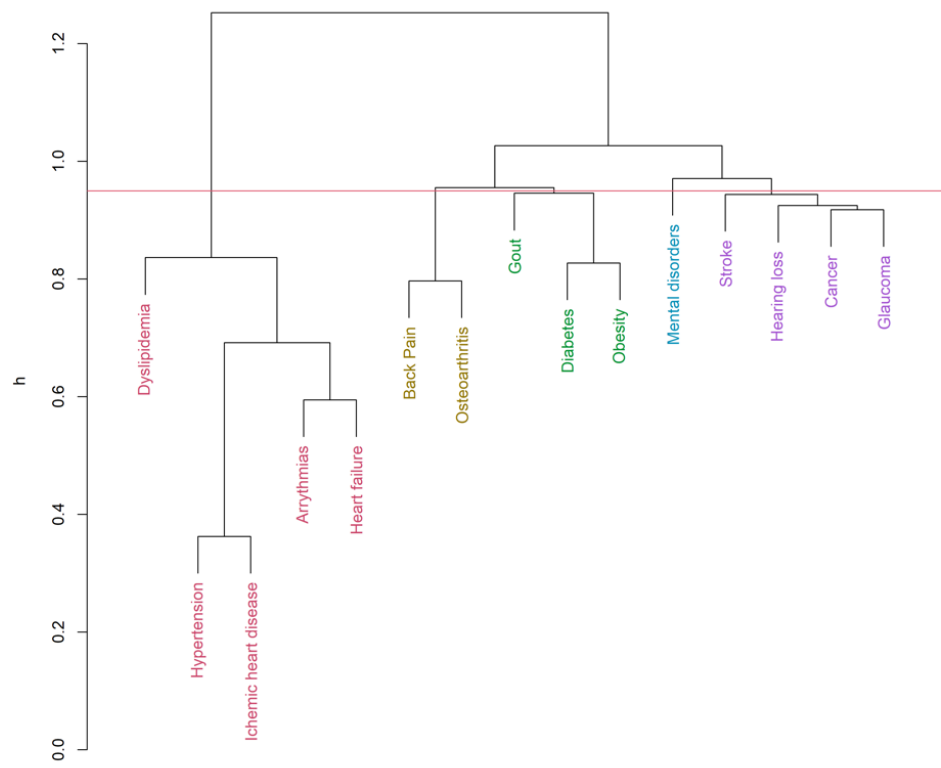
Figure 2. Clusters of comorbidities (COPD group –female, Ward’s method, h = 0.95 , average Silhou- ette width = 0.06, Dunn index = 0.64).